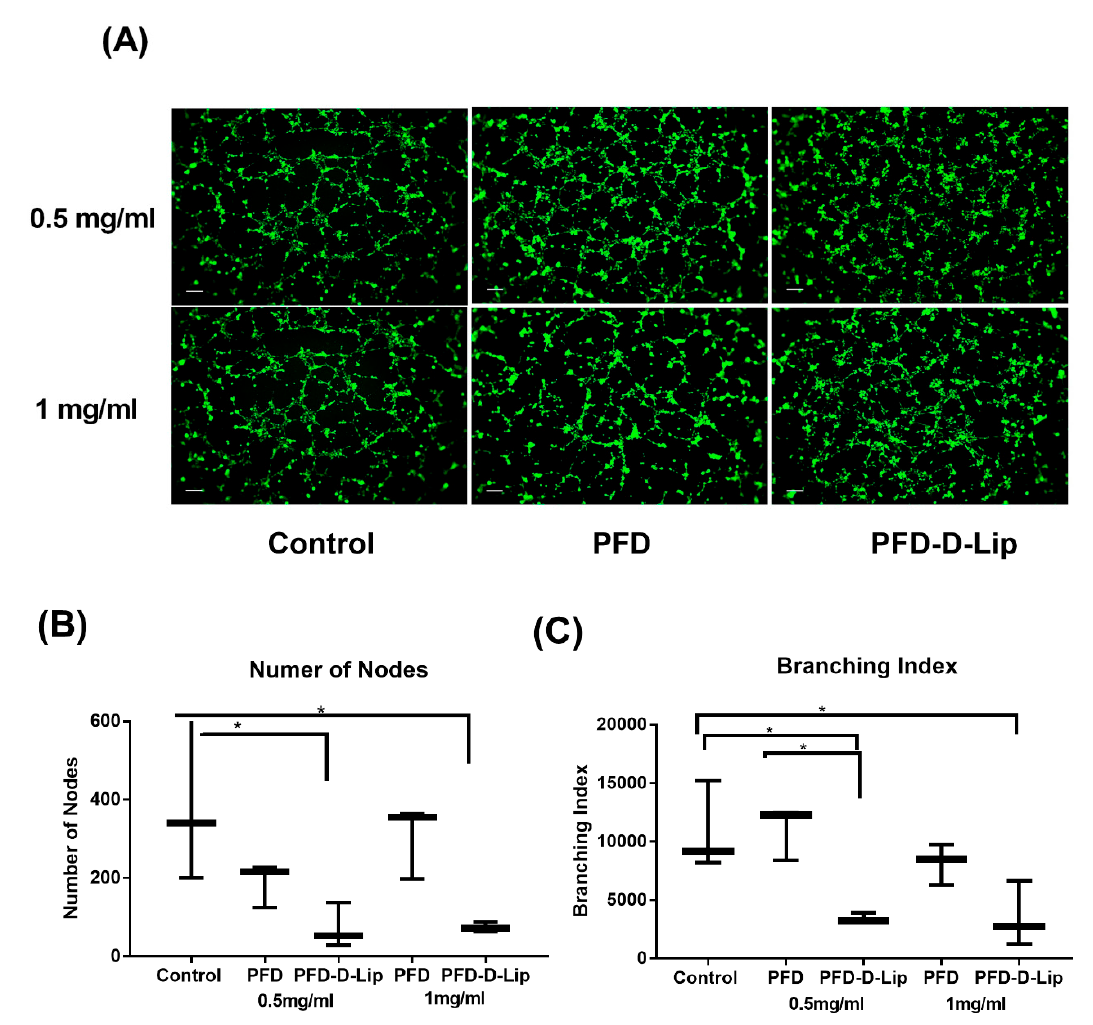
Figure 9. ( A ) Fluorescence microscopy imaging of capillary tube formation by HUVEC cells. Prior to the start of the assay, endothelial cells were treated with 2 μ M calcein AM for 30 min to visualize the cells using Evos-FL fluorescence microscopy. Photographs of HUVEC were taken at 4X magnification. ( B,C ) Quantification of tube formation. Number of nodes ( B ) and branching index ( C ) were calculated